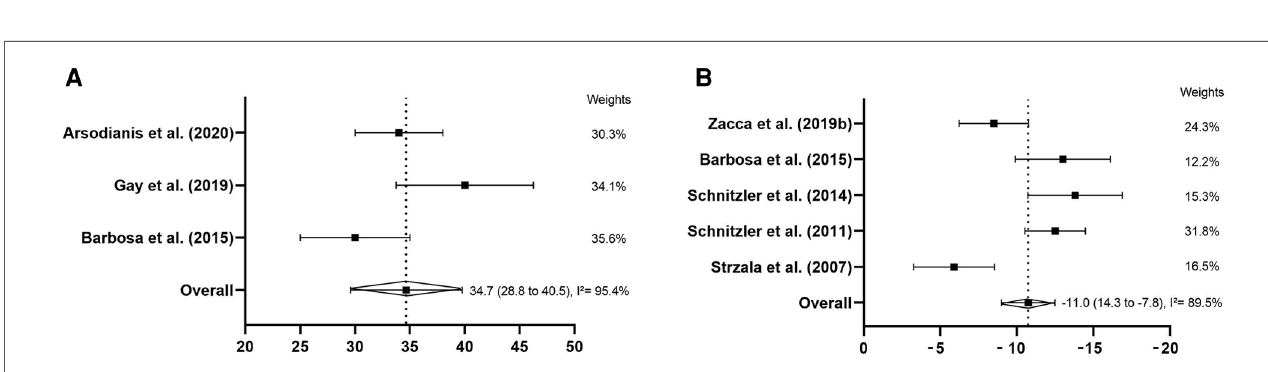
FIGURE 4 Forests plots derived from continuous random-effects models depicting the ef fi ciency ( A : % h p =arm-stroke propelling ef fi ciency) and coordination ( B : % IdC =index of coordination) parameters in 400-m front crawl